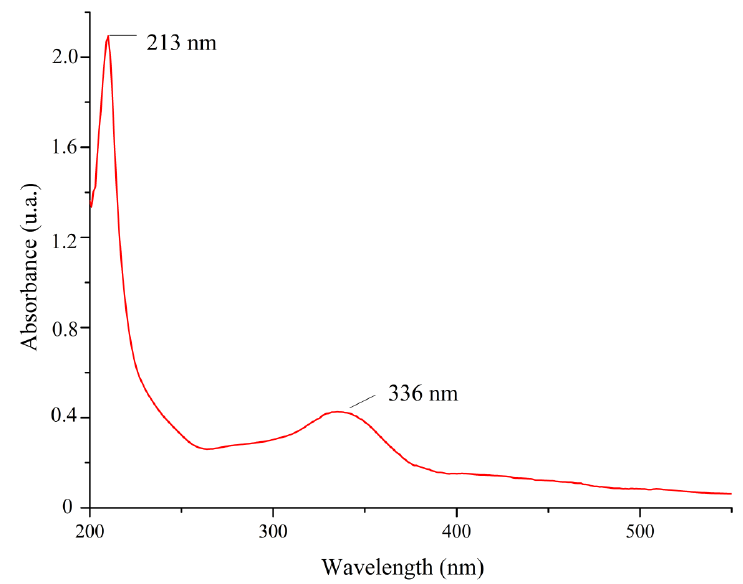
Figure 8. UV-vis spectrum of BBP in DMSO.